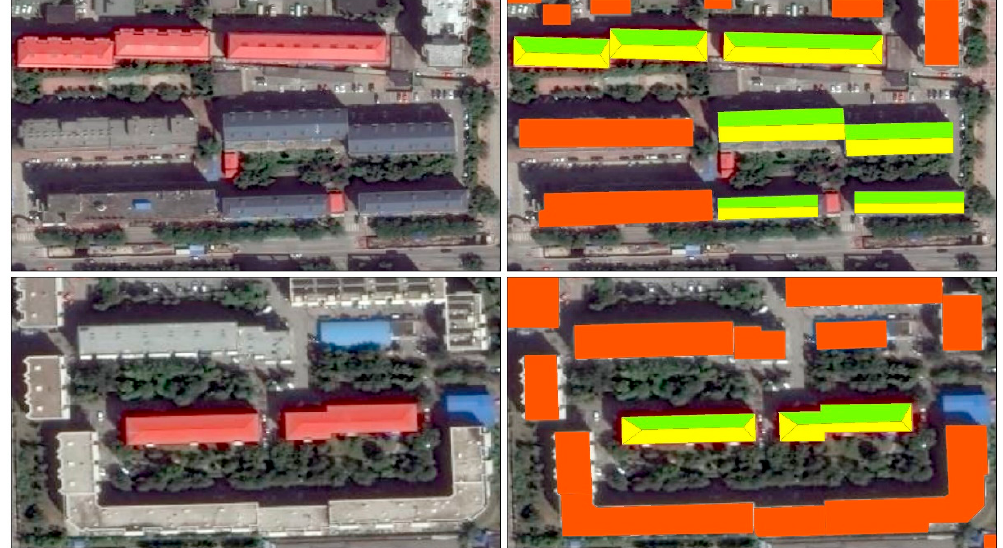
Figure 5. Different types of rooftops (flat rooftops are shown in red and sunny hips and shade hips of pitched roofs are shown in yellow and green, respectively.).